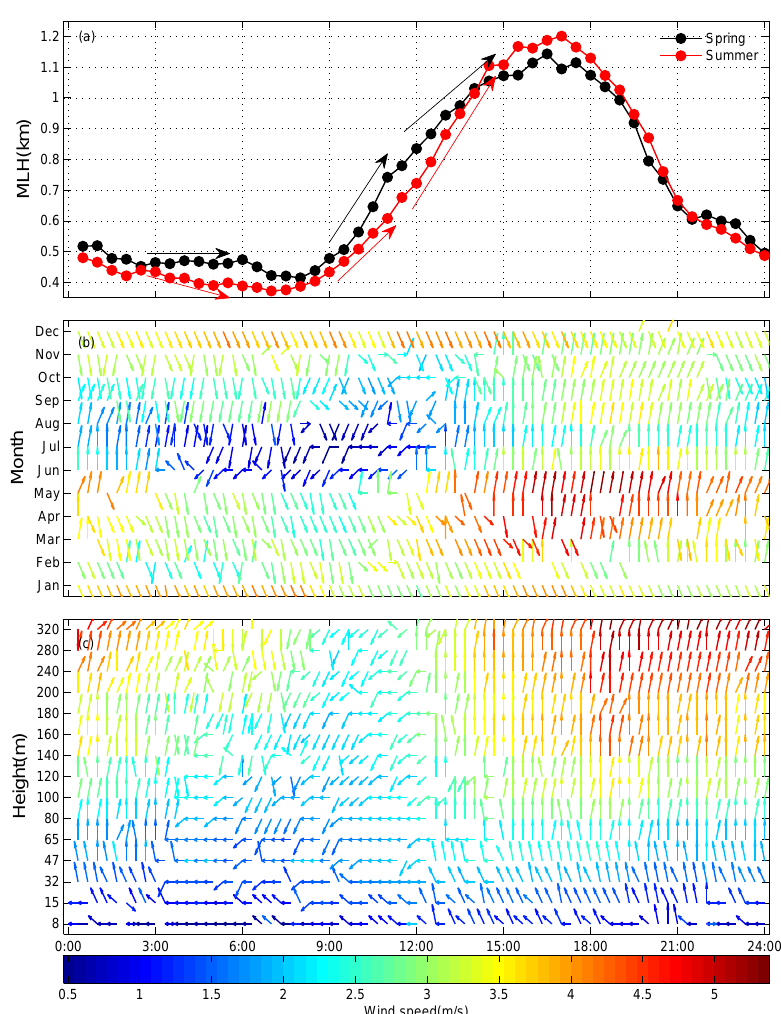
Figure 10. Daily variations in MLH in spring and summer (a) , seasonal wind vectors at 100m (b) , and vertical profiles of wind vectors in July (c) in